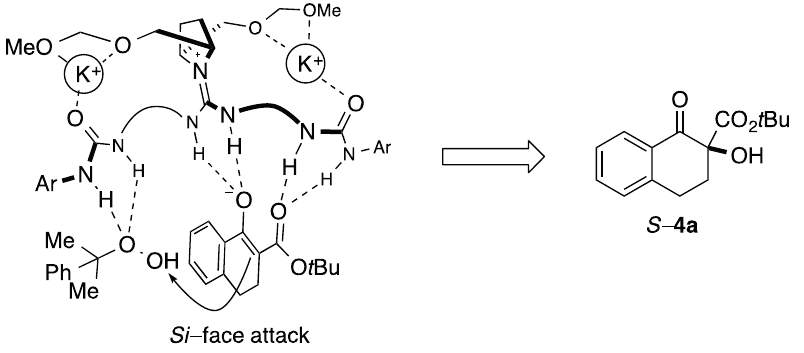
Figure 3. Plausible transition state model of α -hydroxylation of 3a in the presence of 5j